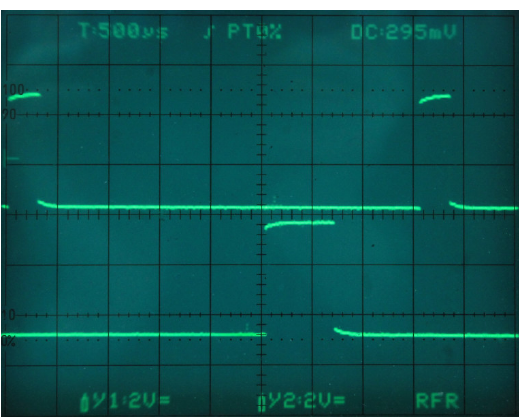
Figure 7. Timing of the acquisition of a single ECG sample (lower trace high period) and of its delivery to the UART (upper trace high period) on the Arduino.